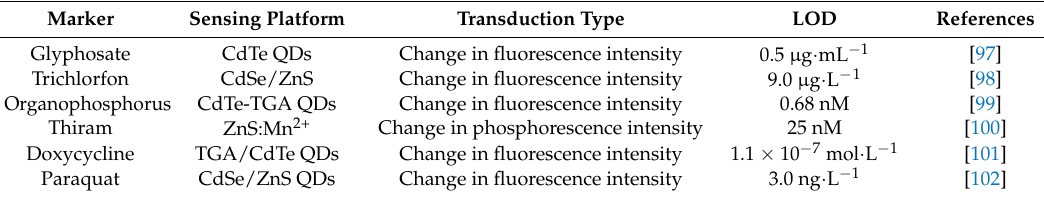
Table 7. QDs-based sensors for pesticides determination.